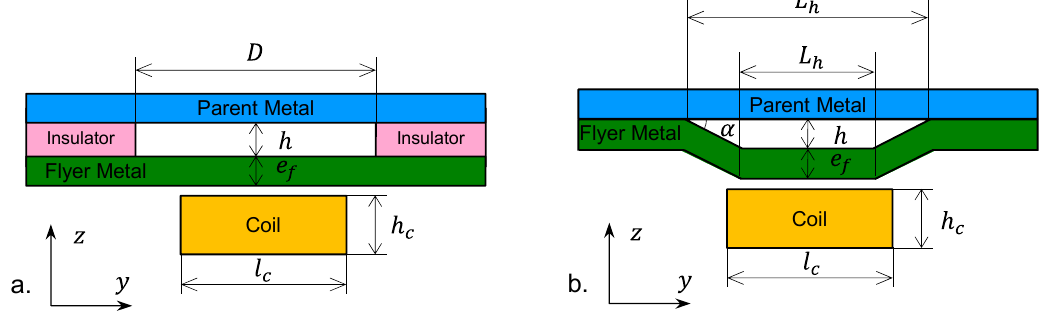
Figure 3. Experimental setup: ( a ) MPW; ( b ) MPSW.